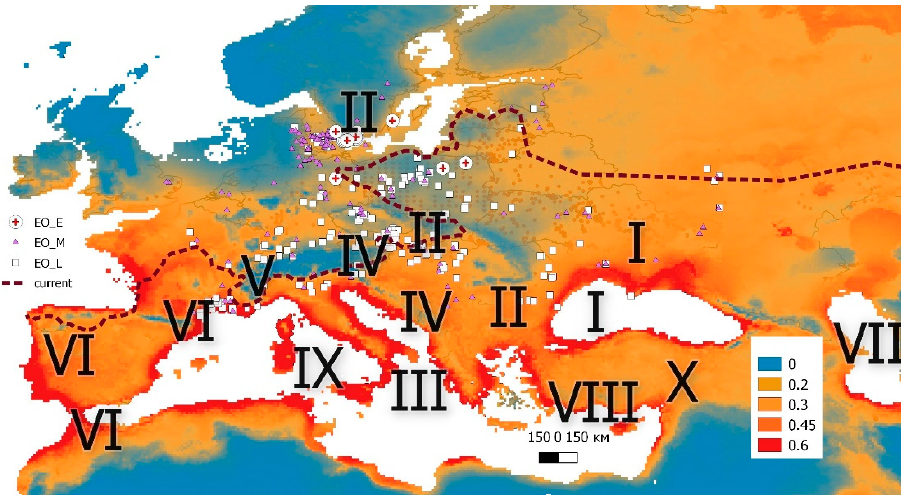
Figure 4. GIS-model of the Early Holocene location of glacial refuges (red) of Europe by E. orbicularis based numerals refer to mtDNA: I-X [3–5,43–45], Holocene subfossil finds records in Europe: